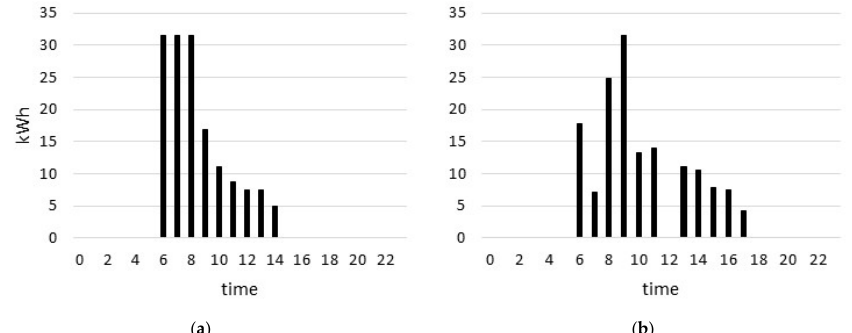
Figure 5. Energy demand due to stochastic and non-stochastic profiles. ( a ) Non-stochastic generated energy demand, ( b ) Stochastic generated energy demand.